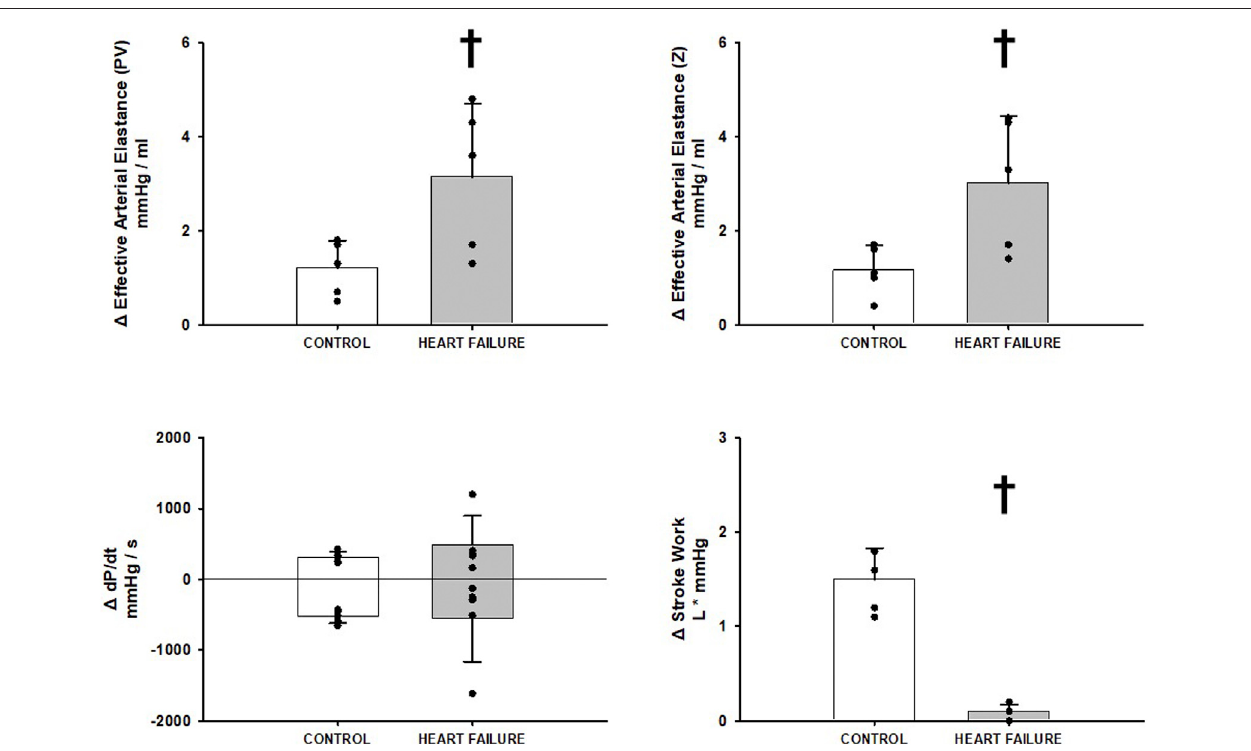
FIGURE 2| Relative change in hemodynamic variables between rest and rest with baroreceptor unloading viabilateral carotid occlusionin control (white bars) and after induction of heart failure (grey bars). Data reported as means with errors bars depicting the standard error of the mean. Observed data points are overlain on corresponding bar graphs. Statistical signi fi cance depicted as † where p < 0.05. ( N = 5).